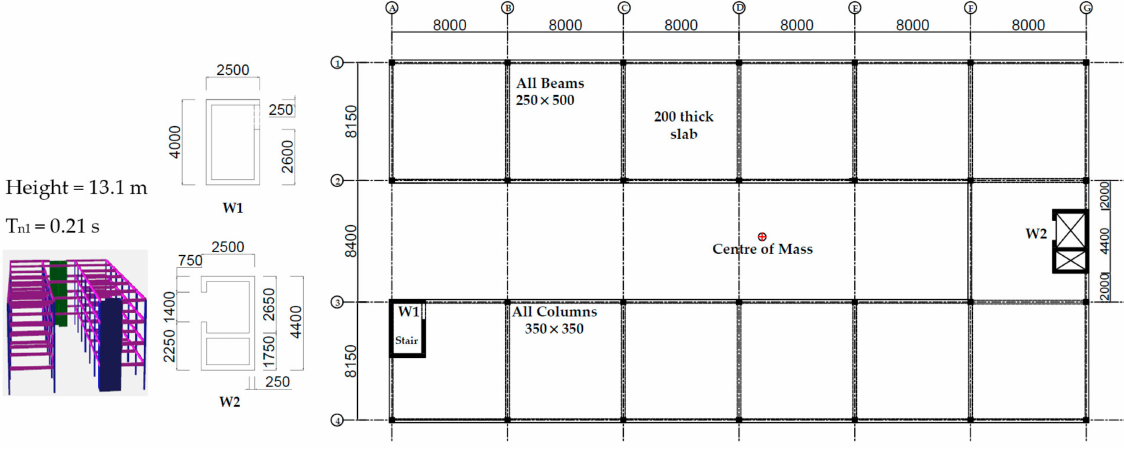
Figure 15. Floor plan, structural layout, and elevation view of CSB 5 (all dimensions are in